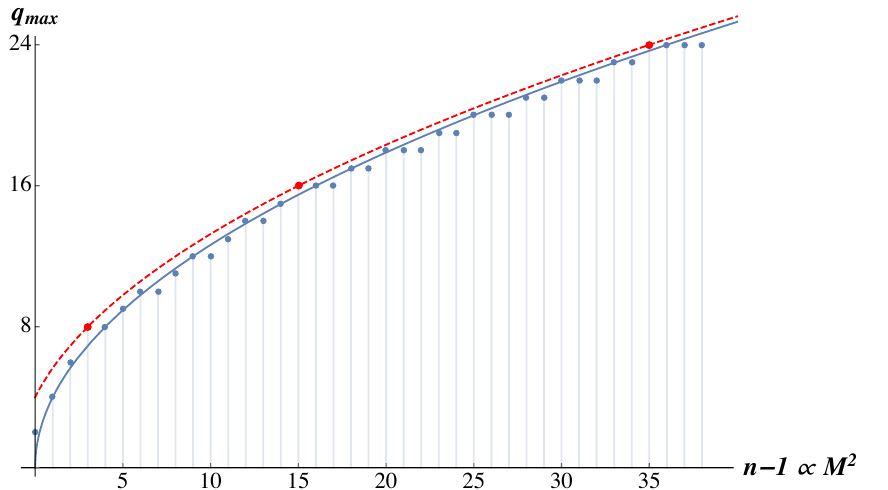
[4] (cid:12)bration over F 2 with (x ; y) = 112